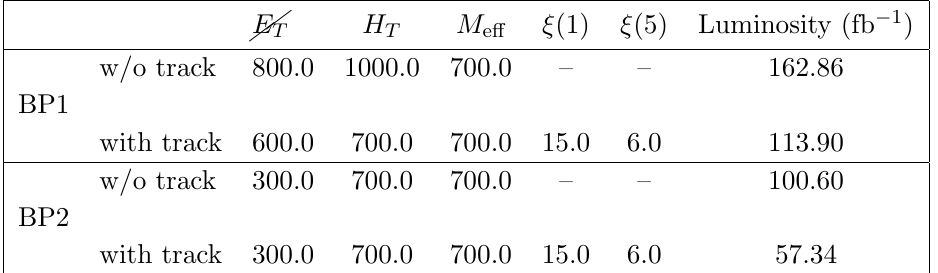
Table 6 . Same as in table 5 for MSSM benchmark